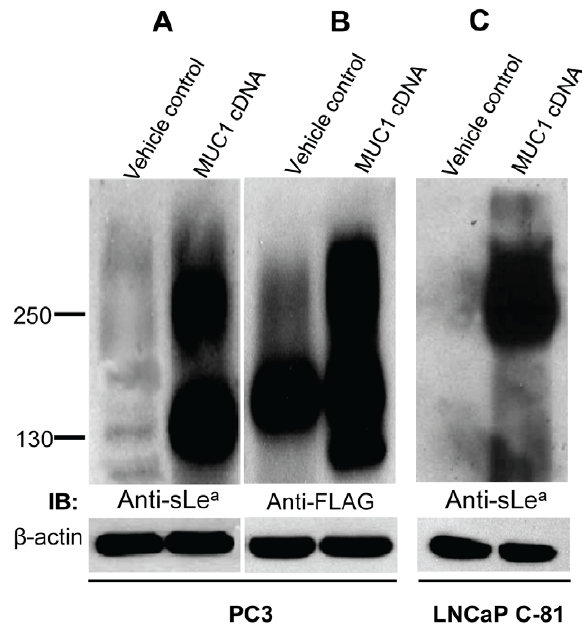
Figure 8. Transfection of PC3 and LNCaP C-81 cells with MUC1 cDNA results in production of sLe a . Full length MUC1 cDNA composed of tandem repeats and N-terminal FLAG epitope was used to transfect PC3 and LNCaP C-81 cells. After 72 h, cell lysates from both vehicle control and MUC1 cDNA-transfected cells were analyzed by sLe a (KM231) western blotting. The MUC1 band corresponding to 250 kDa appeared after MUC1 cDNA transfection in both cell lines. The 130 kDa band in frame A probably represents truncated MUC1 in MUC1 cDNA- transfected cells. Antibodies did not detect any sLe a band in vehicle- treated cells. For equal protein loading, b -actin was used and run on 12% SDS-PAGE.